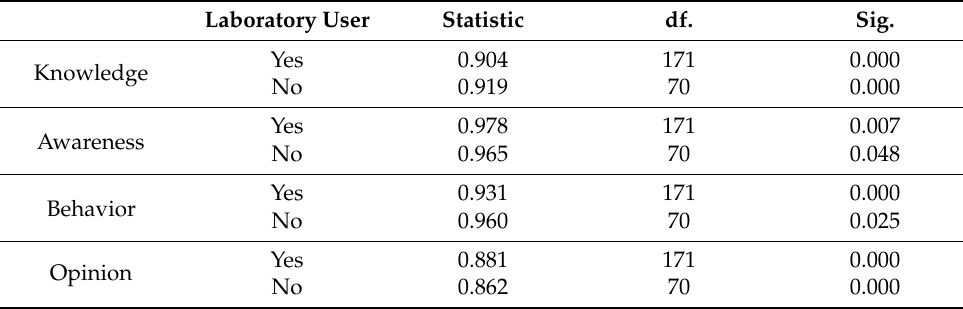
Table 4. Normality test for phase 1 analysis using Shapiro – Wilk test.